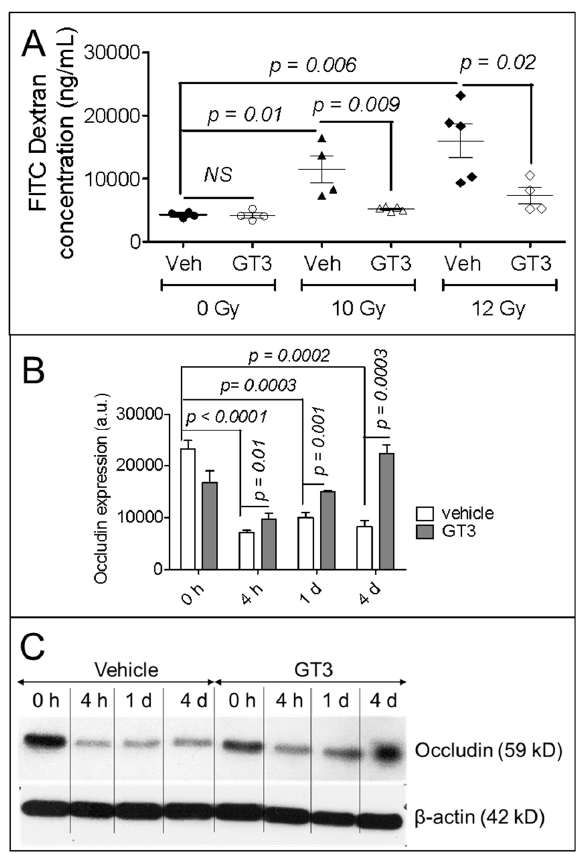
Figure 2. Effects of GT3 pretreatment on intestinal function. A : Functional activity was measured on day 4 after 10 Gy or 12 Gy TBI with an intestinal permeability assay, as described in the Methods; B : Densitometry of immunoblot showing time-dependent change in occludin in intestinal tissue from irradiated or sham-irradiated mice, with or without GT3 pretreatment 24 h before exposure to TBI; C : Representative immunoblot of occludin at different time points. Data represent the mean ± SEM.